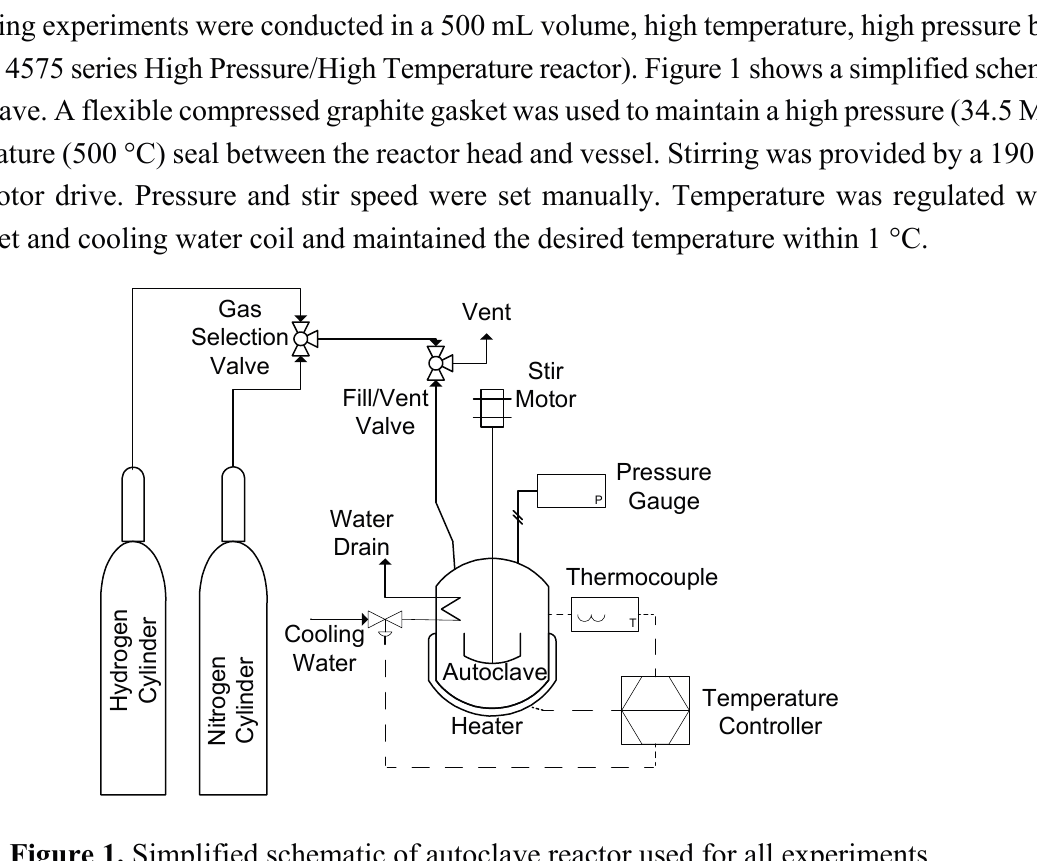
Figure 1. Simplified schematic of autoclave reactor used for all